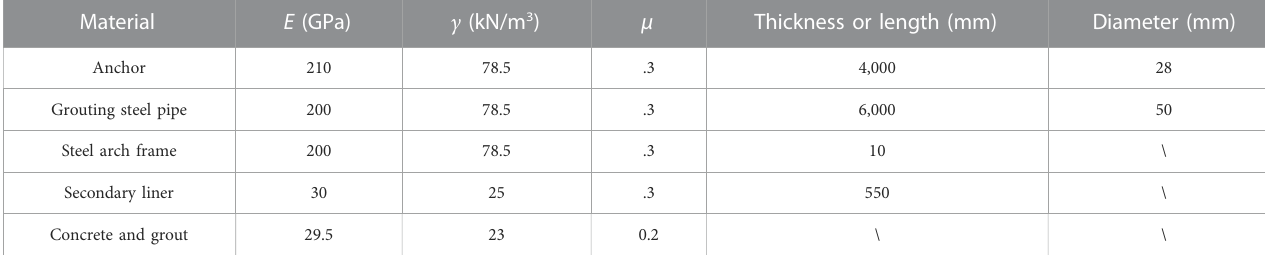
TABLE 3 Material parameters of the supporting